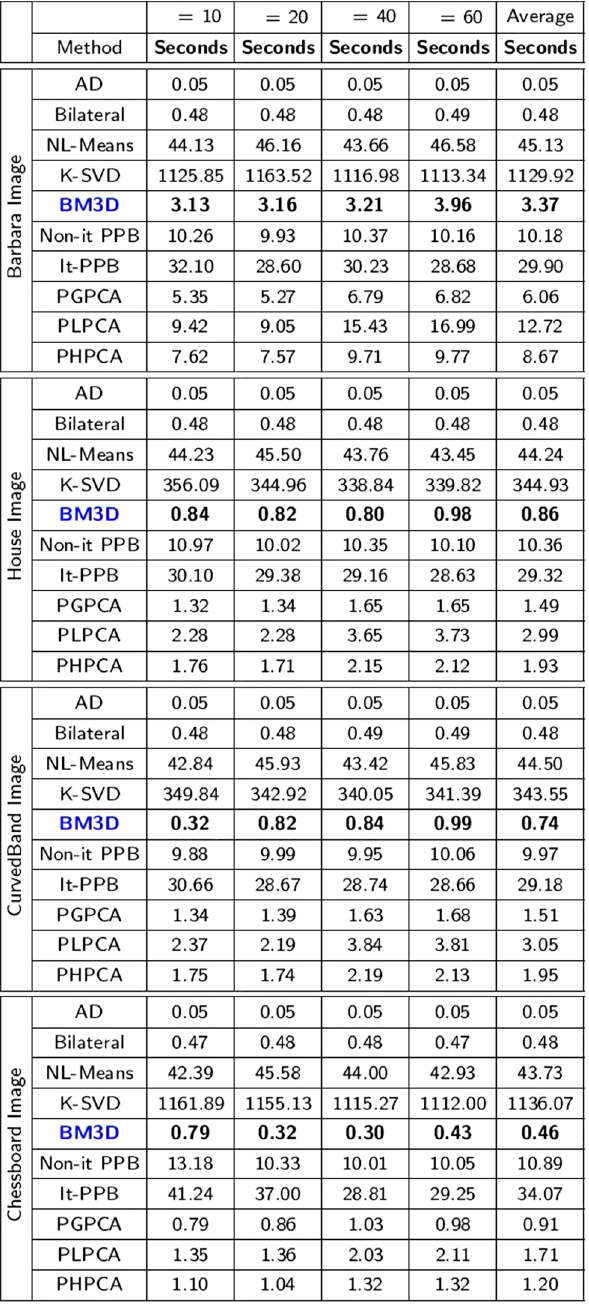
N hard : step size for searching the patches inside the step1 search